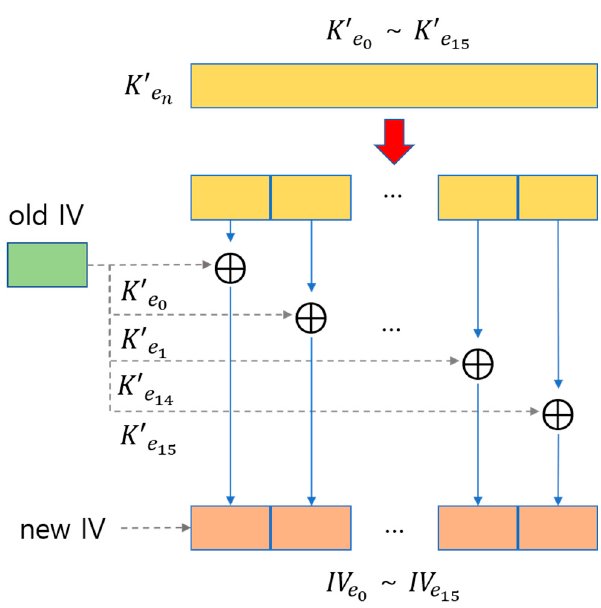
Figure 10. Diagram showing the process of changing IV.